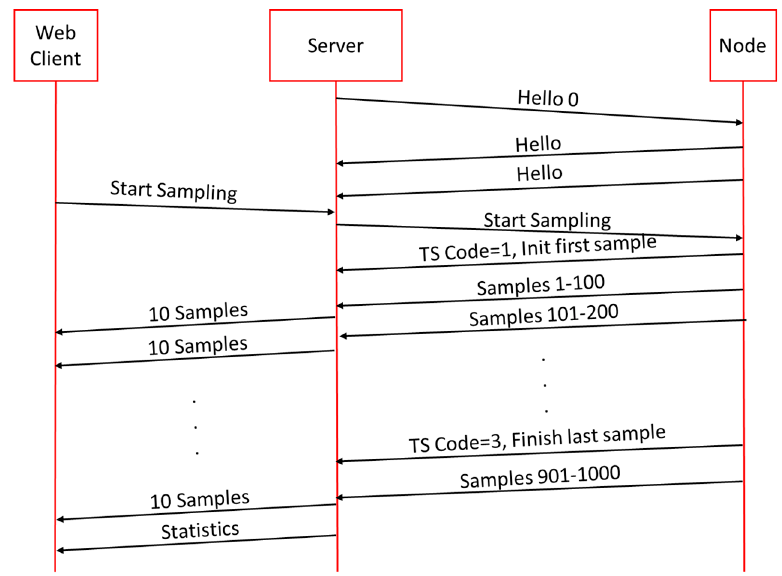
Figure 7. Sequence of one block of 1000 samples.